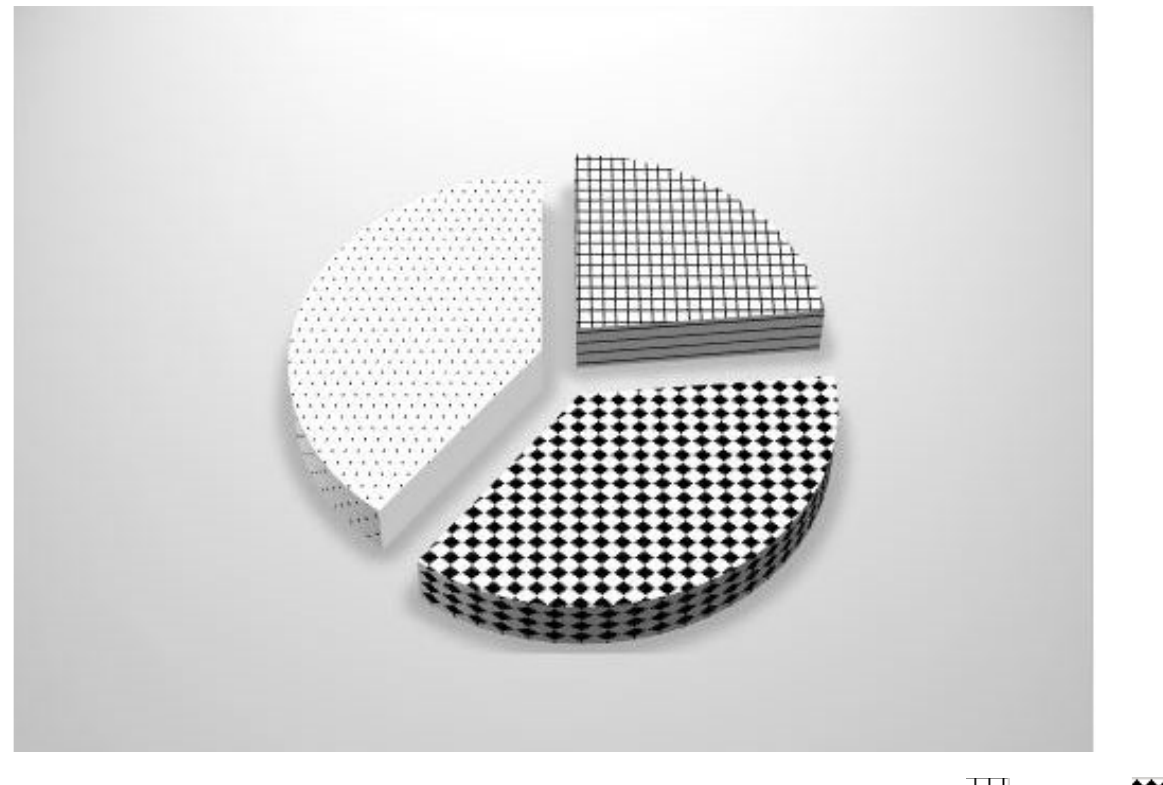
Figure 3. Distribution of ventilation status in the dwellings: functional 23% , faulty 37% or absent 40% .